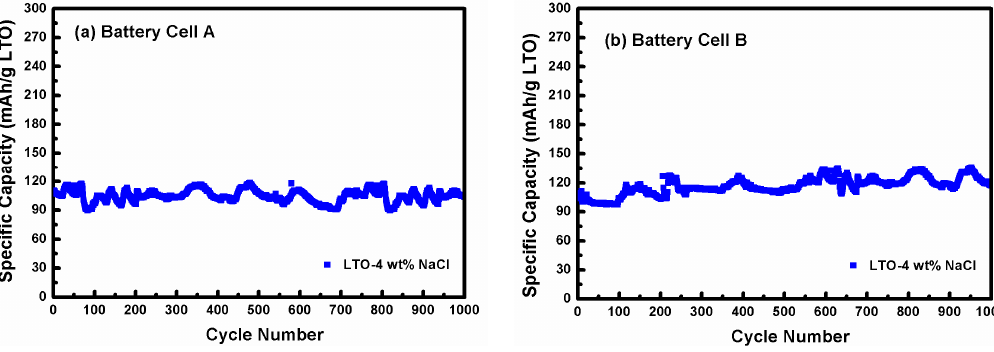
Figure A3. Cycle performances of various LTO-4 wt % NaCl/LFP battery cell at 10 C-rate. References 1.